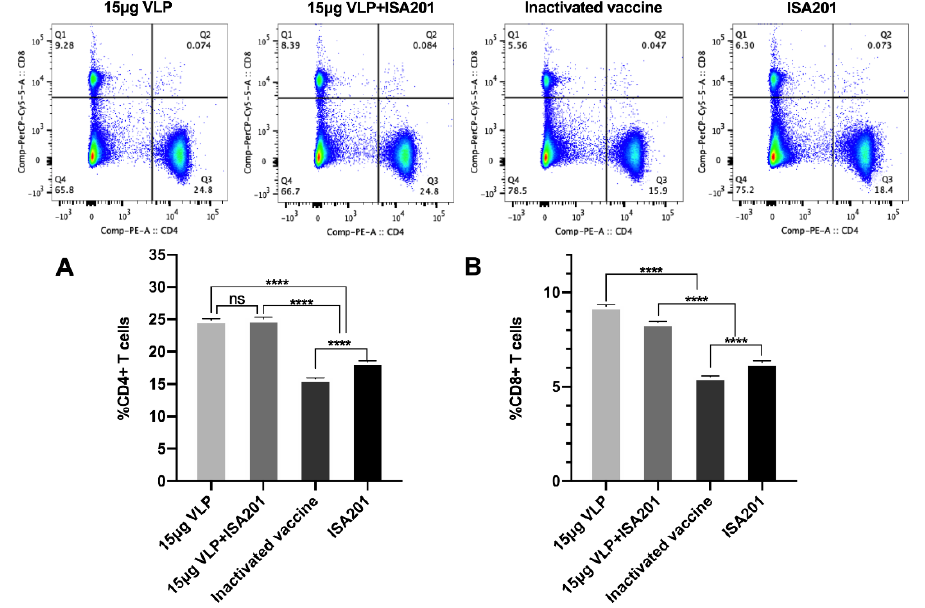
Figure 7. The ratio of CD3 + CD4 + T cells and CD3 + CD8 + T cells in splenocytes. Mice were immunized with 15 μg VLPs with or without ISA201 adjuvant, commercial BVDV inactivated vaccine, or ISA201 adjuvant alone; splenocytes were collected on day 28 post-prime immunization and re-stimulated with the same antigen as those used for immunization, and flow cytometry was used to detect the ratio of CD3 + CD4 + T cells ( A ) and CD3 + CD8 + T cells ( B ). Error bars are standard error of the mean. GP:0.1234 (ns), <0.0001 (****).